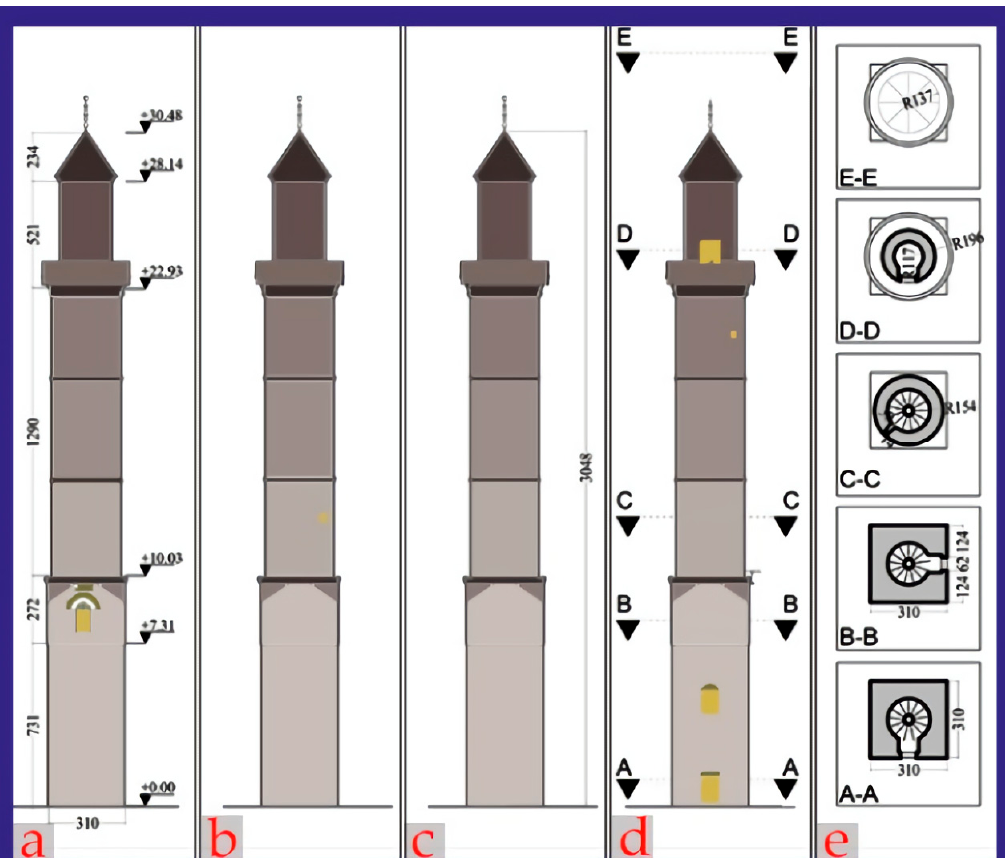
Figure 8. Bitlis Ulu Mosque’s minaret view and plans: ( a ) east elevation; ( b ) west elevation; ( c ) north elevation; ( d ) south elevation; ( e ) plans.